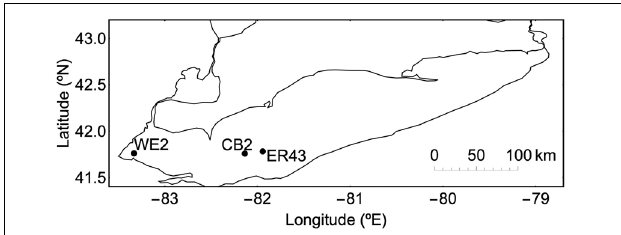
FIGURE 1 | Map of Lake Erie showing the three sampling locations in the central (CB2 and ER43) and western basins (WE2) of the